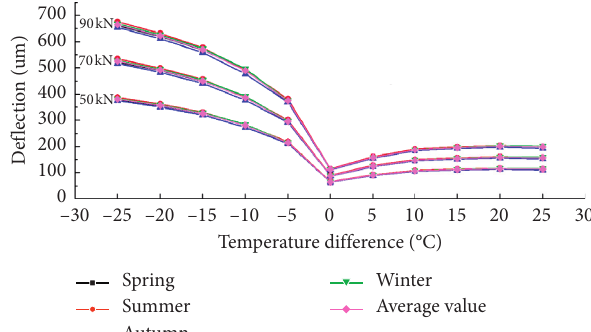
Figure 3: Deflection of plate angle load center point under coupled action of temperature and three-stage load for each